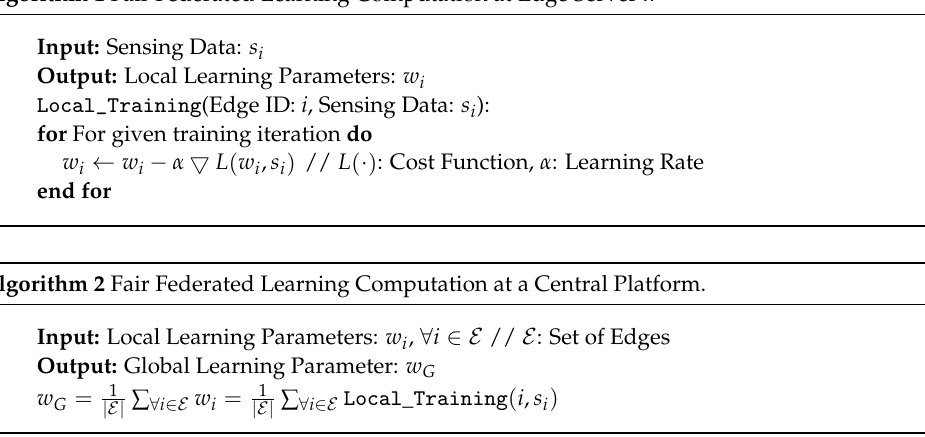
Algorithm 2 Fair Federated Learning Computation at a Central Platform.